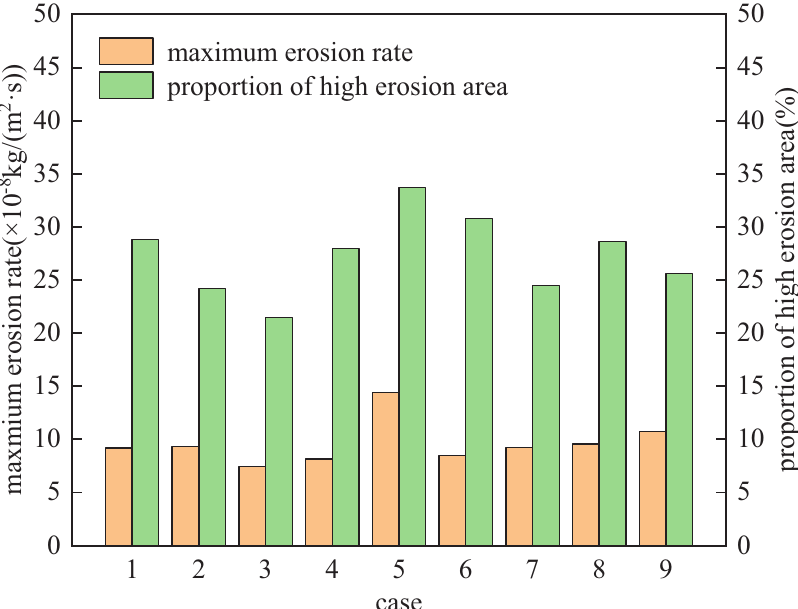
Fig. 12. Maximum erosion rate and proportion of high erosion area simulated by the nine groups.